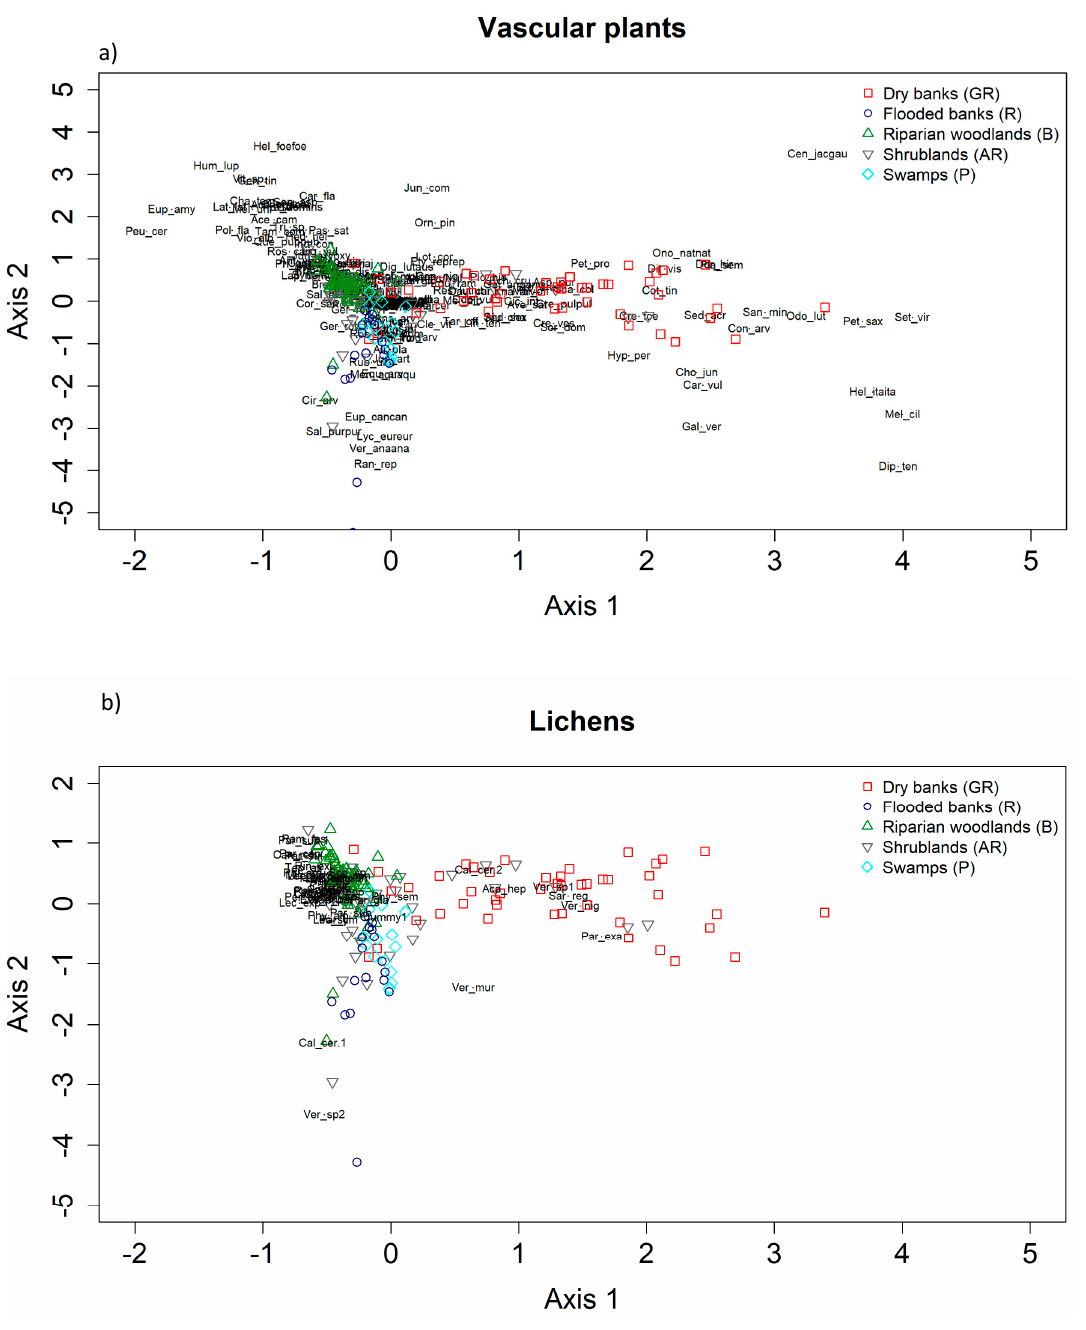
Figure 4. ( a , b ) Predictive Co-CA biplot of plant species composition ( a ) and lichen species composition ( b ) using abundance data. In each plot, species are positioned according to their loadings, with respect to normalized plot scores derived from the plant composition data. Symbols show the type of riparian vegetation habitat of each plot. The axes were rescaled to the same ranges so that sites occupy the same position in both plots. Explanations of species abbreviations are reported in Appendix I.